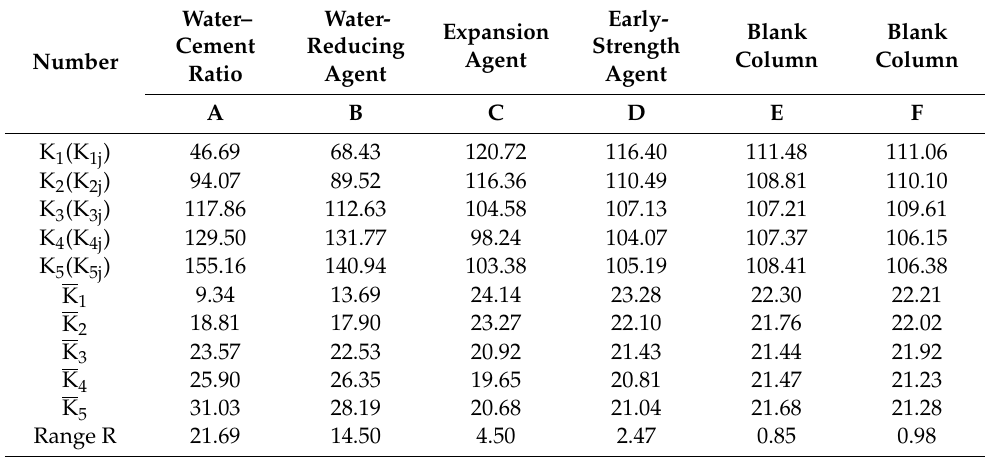
Table 5. Range analysis of orthogonal test results for